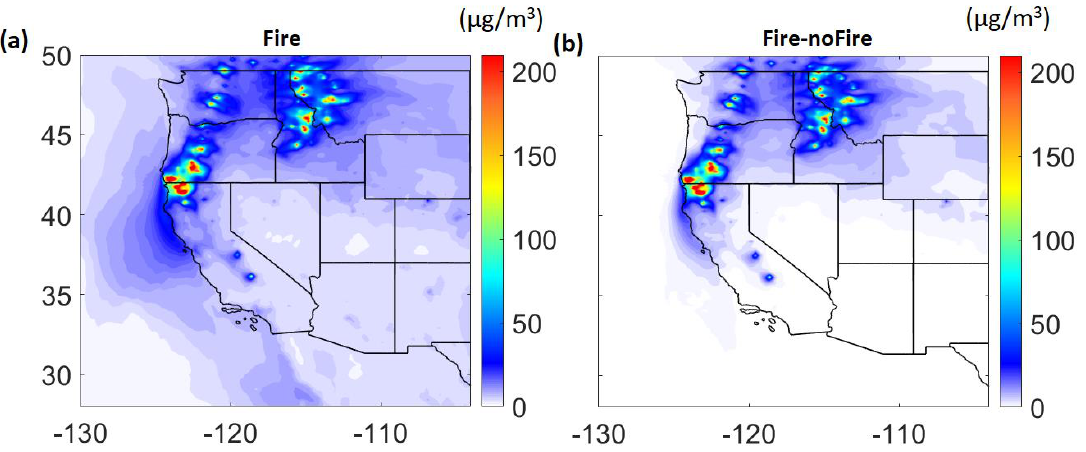
Figure 15. Spatial distribution of average ( a ) surface PM 2.5 concentration in µg/m 3 from the ‘Fire’ simulation, and ( b ) difference in surface PM 2.5 concentration in µg/m 3 between the ‘Fire’ and ‘noFire’ simulations for the first half of September 2017.